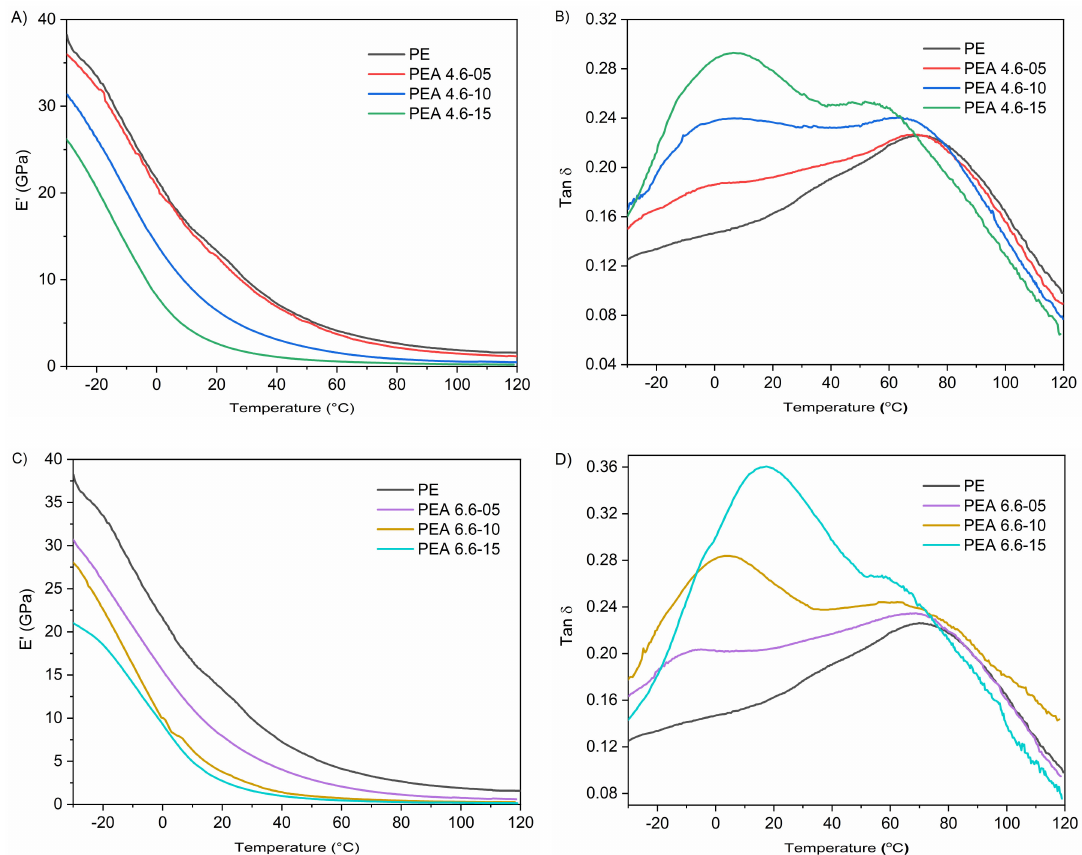
Figure 7. Storage modulus (E’) and tan δ values of the PEAs after UV curing. PEAs with amido diol 4.6 ( A , B ) and PEAs with amido diol 6.6 ( C , D ).